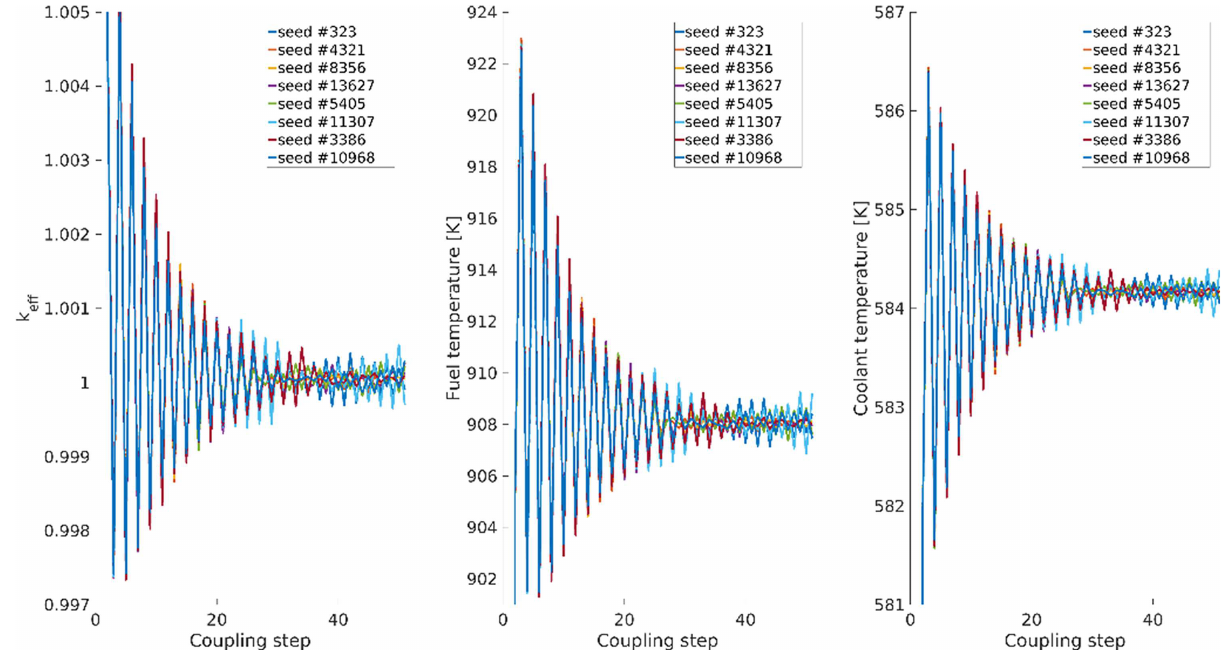
Fig. 10. Convergence in static GK mode, evolution of the criticality ( k eff ), fuel, and coolant temperatures with the coupling steps.